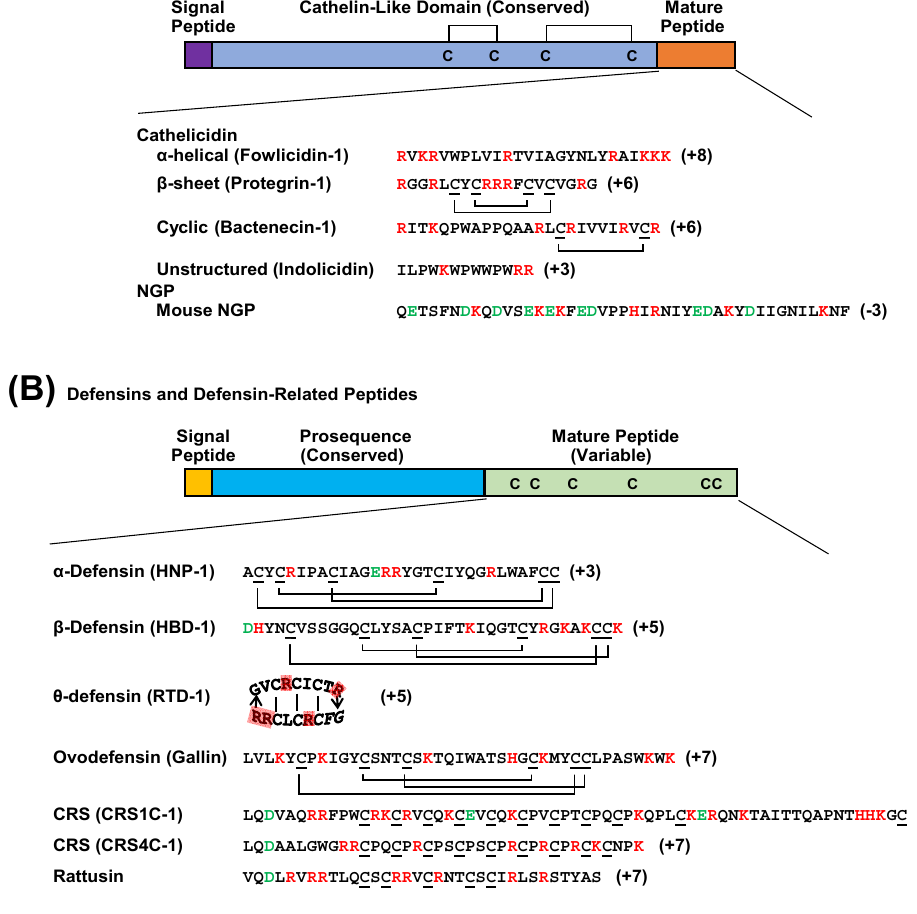
Avian-specific ovodefensins contain six cysteines but with a different spacing pattern from 9, and 5 cysteine residues, respectively, that presumably form intermolecular disulfide bonds.